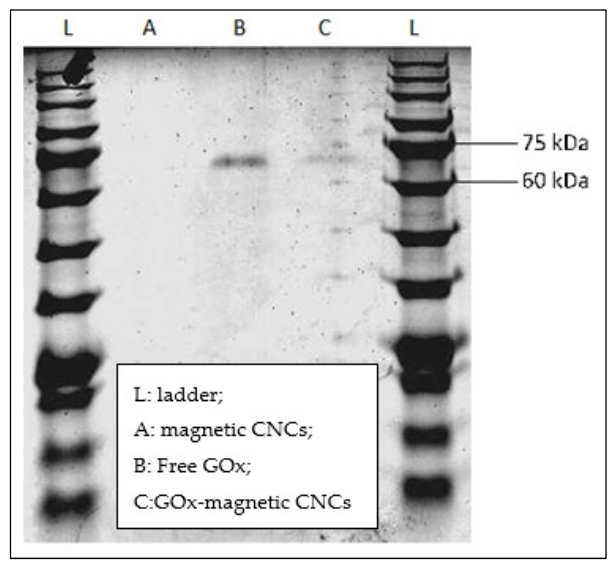
Figure 3. SDS ‐ PAGE showing the attachment of GOx on magnetic CNCs. ( L : ladder; A : magnetic CNCs; B : Free GOx; C : GOx ‐ magnetic CNCs).